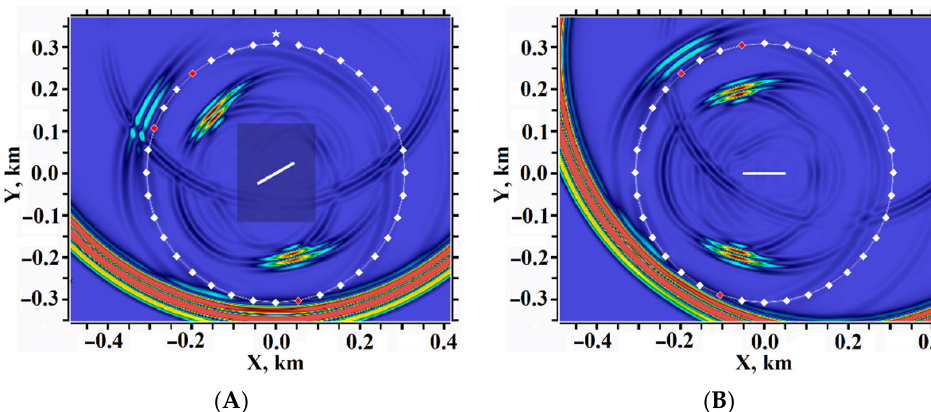
Figure 8. Velocity modulus snapshots, time moment of 0.8 s, distance in km, diamonds mark the receivers’ positions, the asterisk denotes the source position: ( A ) with an overlapping curvilinear mesh;( B ) without an overlapping curvilinear mesh.